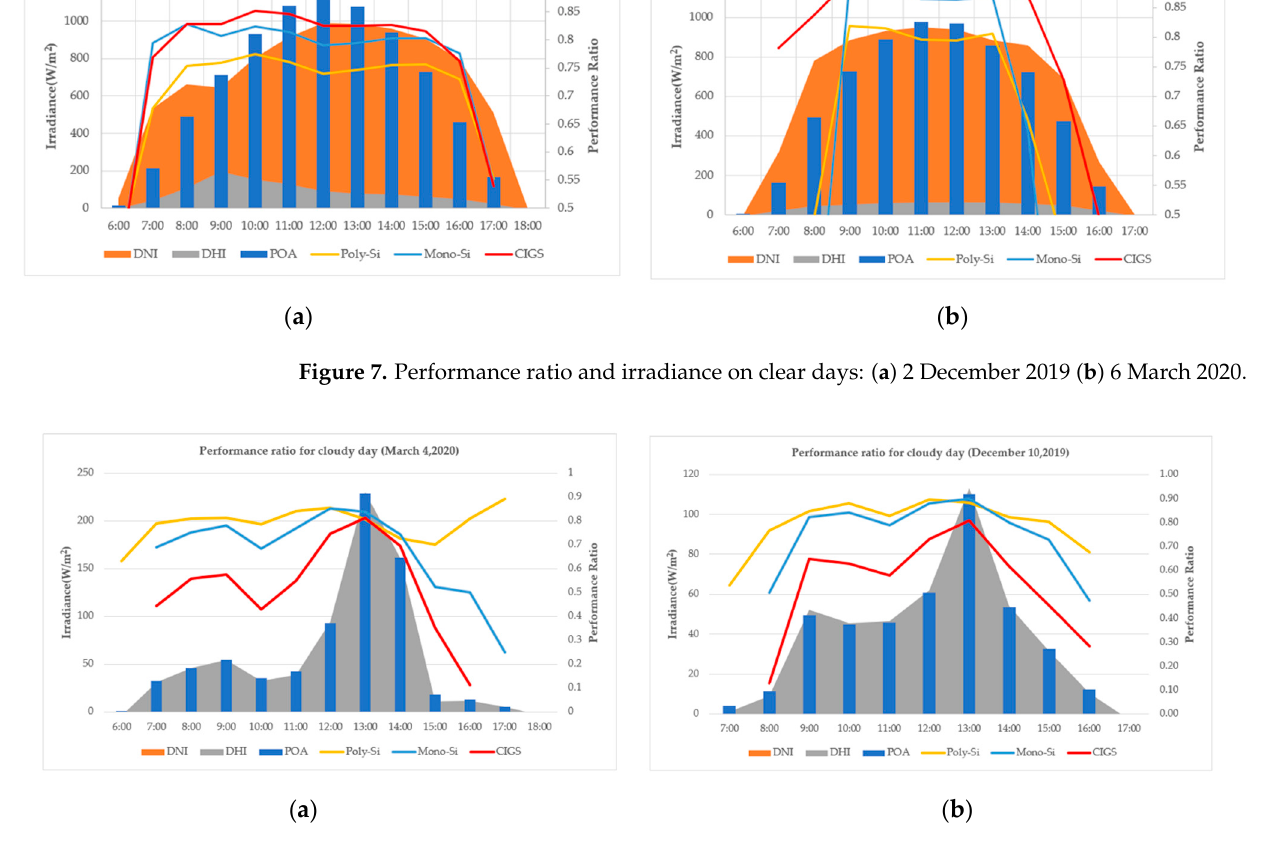
Figure 8. Performance ratio and irradiance on cloudy days: ( a ) 10 December 2019 ( b ) 4 March 2020.